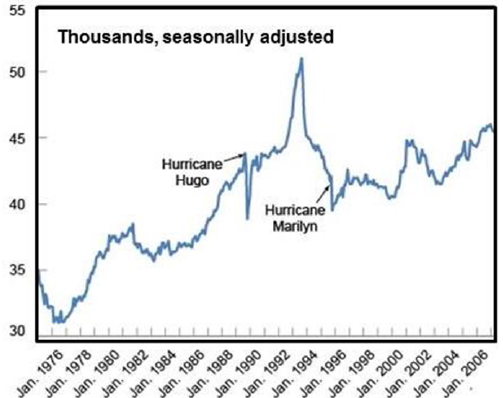
Fig. 3. General Fund Revenues, FY 1995-99, Government of the US Virgin Islands. “Tax and non-tax revenues, not including con- tributions” (Department of Finance, Government of the US Virgin Islands,